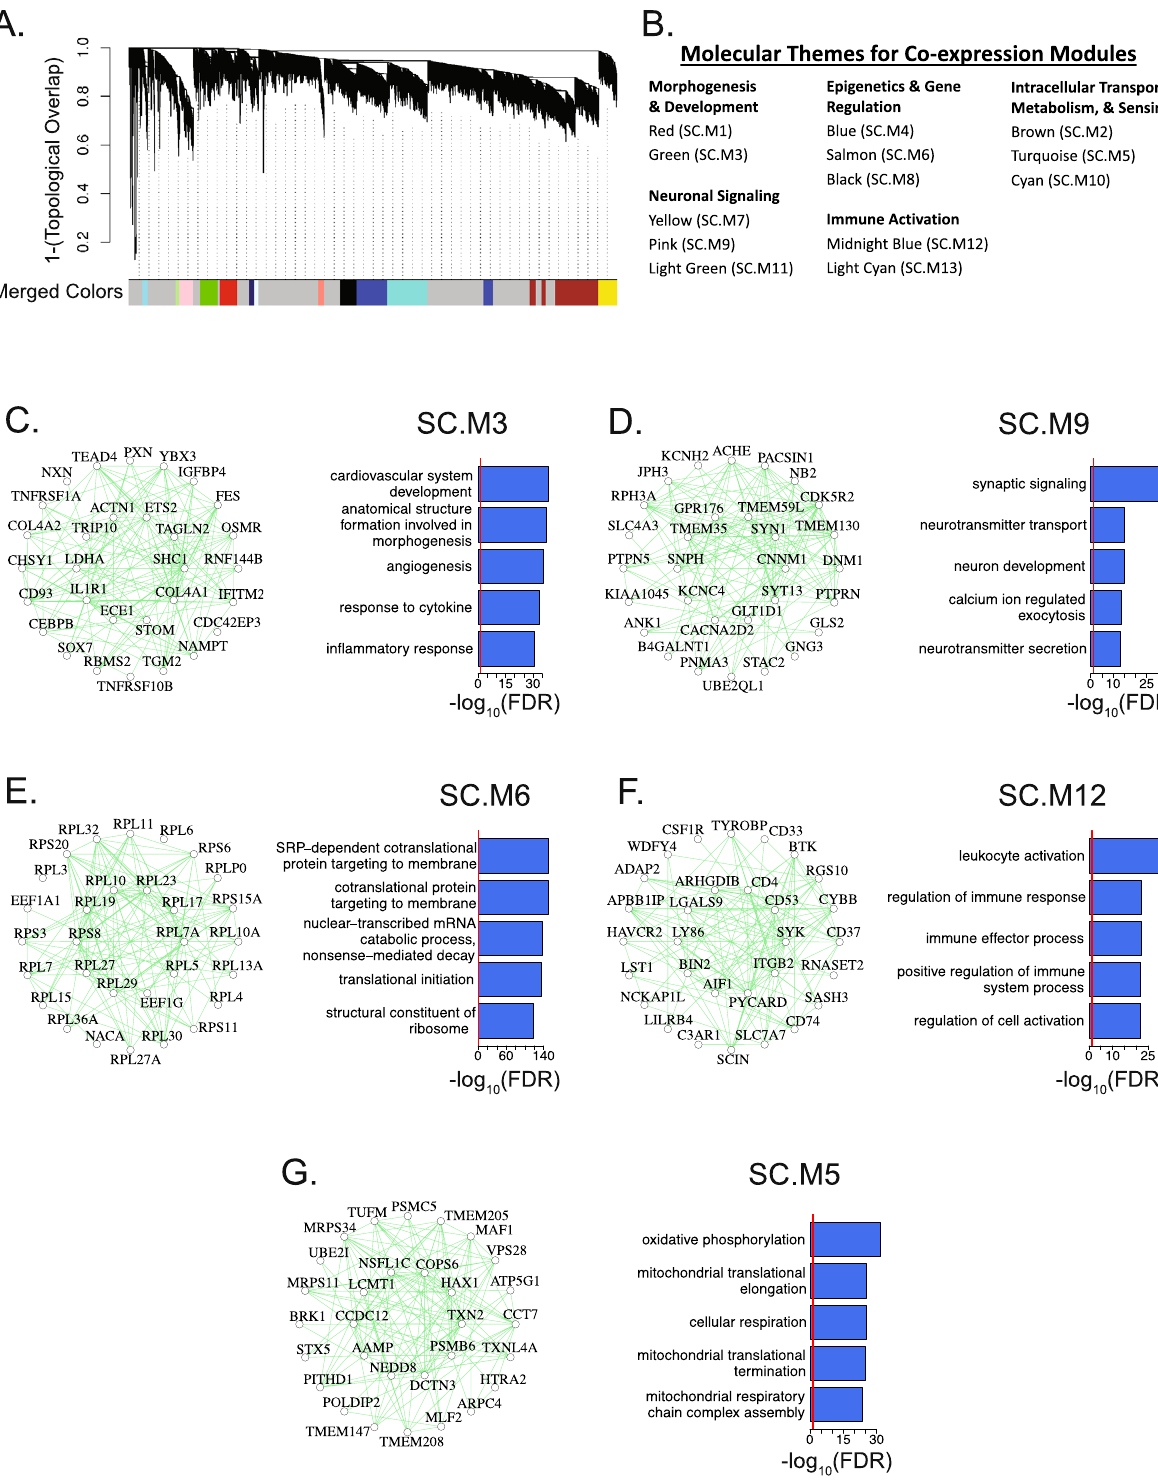
Figure 2. Construction of co-expression network in control cervical spinal cord. ( A ) Dendrogram of the topological overlap matrix for gene co-expression dissimilarity. Co-expression module assignments are shown in the “Merged Colors” track (See Supplementary Fig. S2 for optimization of tree-cutting parameters). Genes that failed to be clustered into a co-expression module were grouped within the grey module. ( B ) Thirteen co-expression modules were categorized into five broad molecular themes based on Gene Ontology (GO) term enrichment and assigned a unique module identifier (SC.M1-13). ( C – G ) Top 30 hub genes and 300 connections for SC.M3, SC.M9, SC.M6, SC.M12, and SC.M5 respectively (left panels). Top 5 enriched GO terms for each of the respective modules (right panels). Red lines mark an FDR corrected p-value threshold of